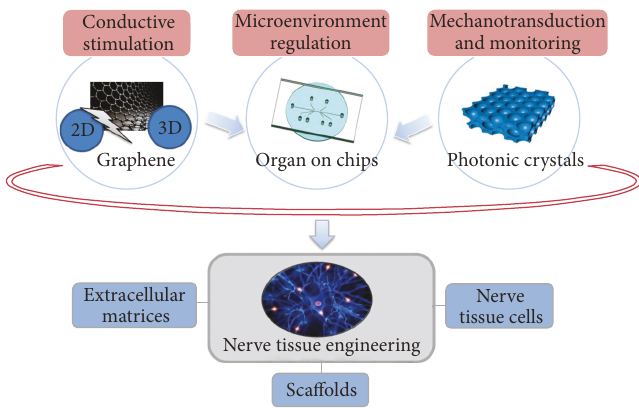
Figure 1: Design of biomaterial and microenvironment by graphene, photonic crystals, and organ-on-a-chip for